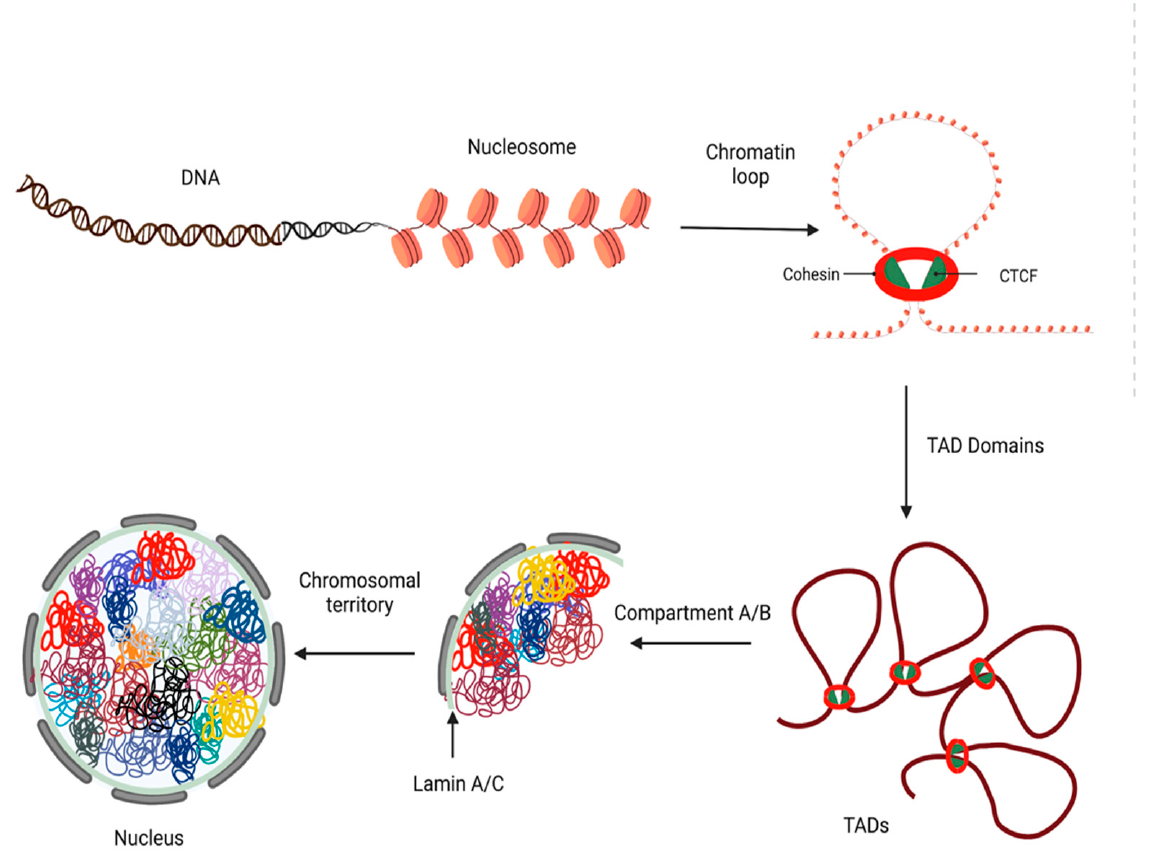
Figure 3. Several levels of organization are present in genomes. Inside the nucleus, DNA (black) is wrapped around nucleosomes (orange), which consist of octamers of core histone proteins H2A, H2B, H3, and H4. Cohesin (red) and CTCF (green) colocalize in the mammalian genomes to form high-order chromatin structures. Chromatin fibers are folded into loops, bringing upstream regulatory elements close to gene promoters. TADs (brown) are formed when chromatin is extruded and insulated in a physical compartment. DNA resides inside chromosome territories (multiple colors), generating non-random arrangements of chromosomes and genes within the nucleus. This figure was created using BioRender.com.